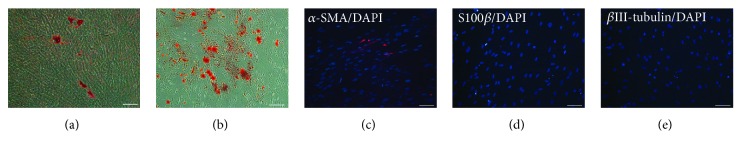
Multiple differentiation potentials of primary adherent FBs. (a) The result of Oil Red-O staining after a 28-day adipogenic induction detected lipid droplets. (b) The result of Alizarin Red staining after a 28-day osteogenic induction detected calcium deposition. (c) The result of immunofluorescence staining detected α-SMA-positive cells. (d) No S100β-positive cells were detected after a 28-day induction for Schwann cells. (e) No βIII-tubulin-positive cells were detected after a 28-day induction for neurons.